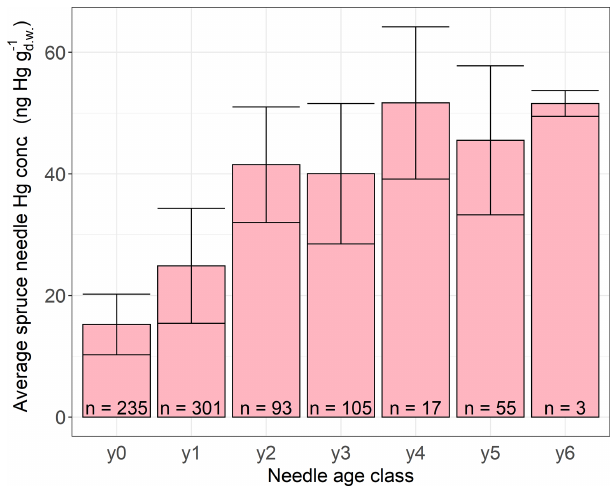
Figure 7. Average Hg concentrations (ngHgg − 1 dle samples of different ages. Needle age class y 0 corresponds to current-season needles flushed in the year of sampling, y 1 corre- sponds to 1-year-old needles, y 2 corresponds to 2-year-old needles, etc. Error bars denote ± 1 standard deviation between multiple sam- ples, n indicates number of